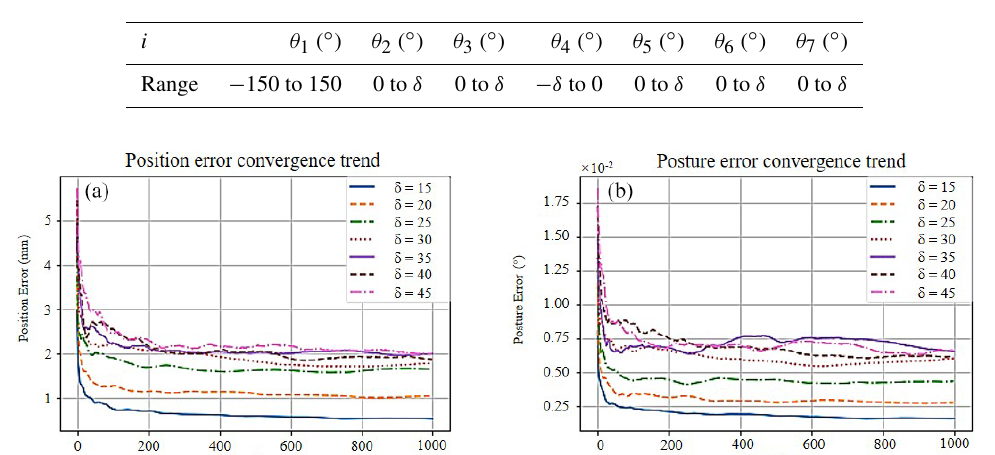
Table 2. Joint angle intervals of the model.